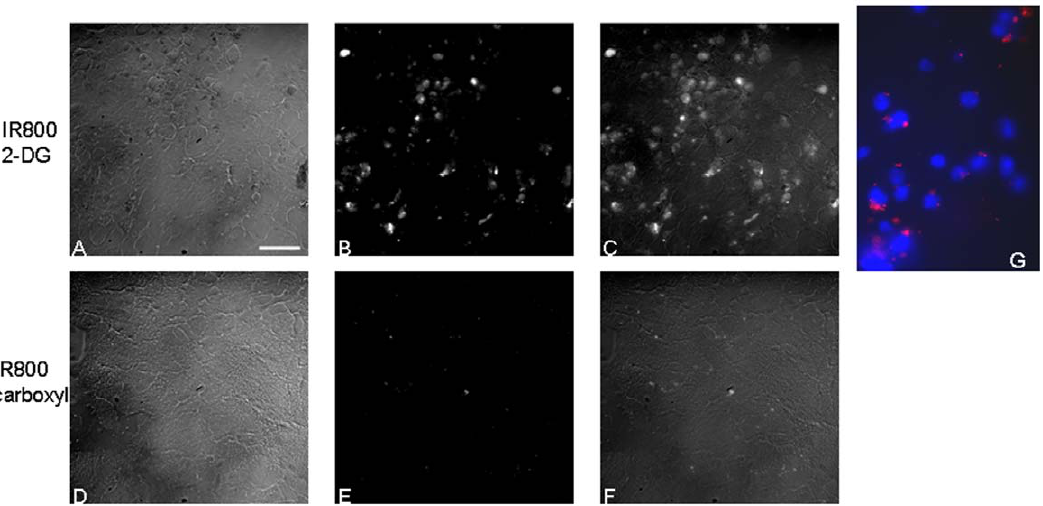
Figure 6. Microscopic fluorescence imaging determined localization of the 2-DG dye. The unstained frozen sections of tumor bearing brain tissues, also used in Fig. 5, were scanned under dark field (A and D). Near infrared signals (B and E) of the same fields detected with an infrared filter were overlaid on the dark field images (C and F). Significantly higher signal was seen in tumor tissues of the mouse injected with the 2-DG dye, compared to the one with control dye. Co-staining of nuclei of tumor cells with DAPI indicated cytoplasmic localization of the 2-DG dye (red;